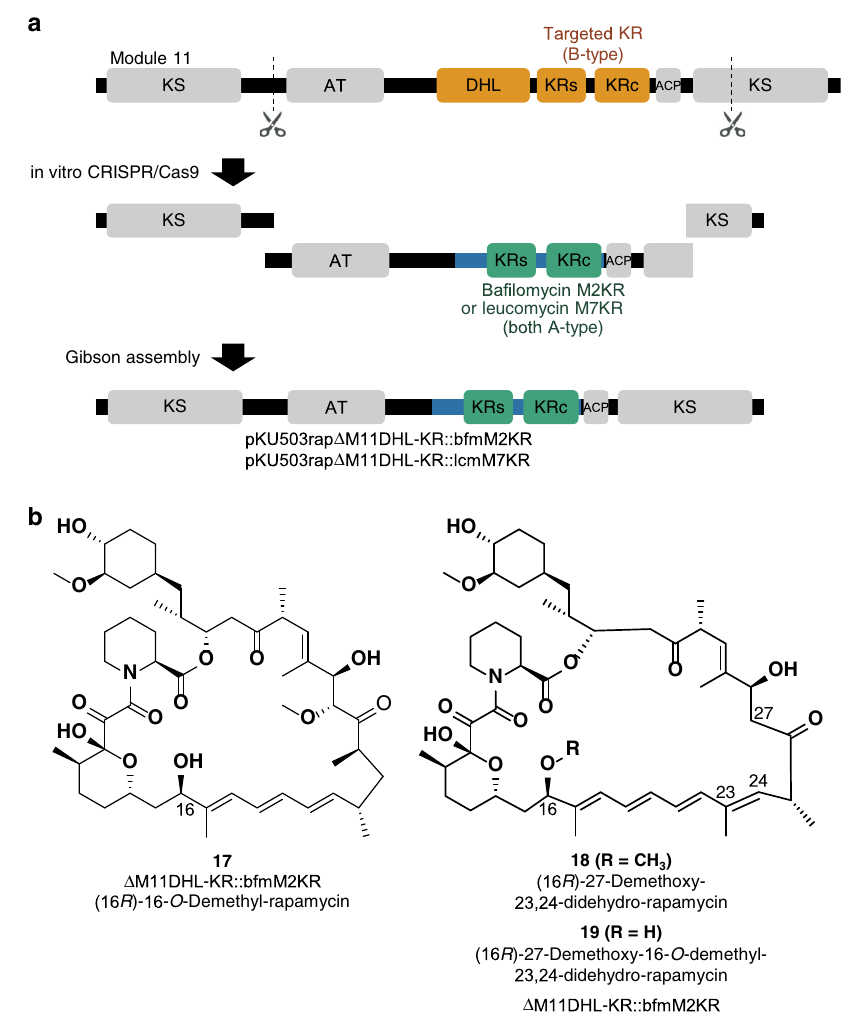
Fig. 4 Inversion of the stereochemistry of one of the hydroxyl groups. a Schematic representation of the swapping of the reductive loop of module 11 with the corresponding region of module 2 from ba fi lomycin PKS. b Structures of 17 , 18 and 19 .